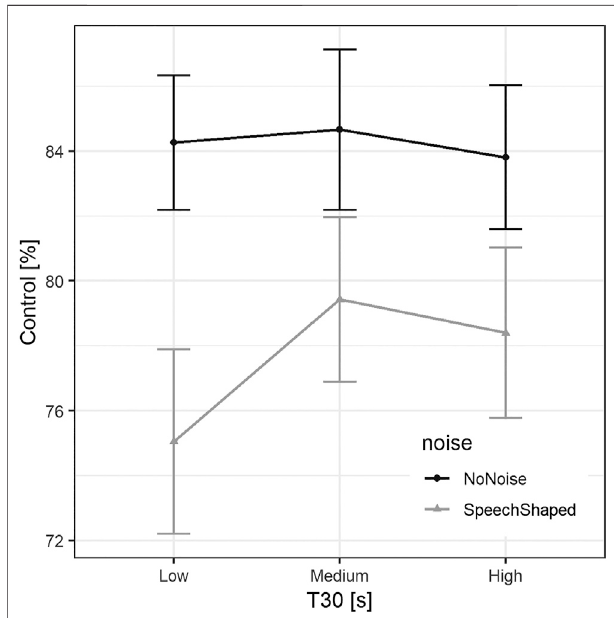
FIGURE 7 | Mean self-reported vocal control in % across participants per T30. The error bars indicate ± standard error.